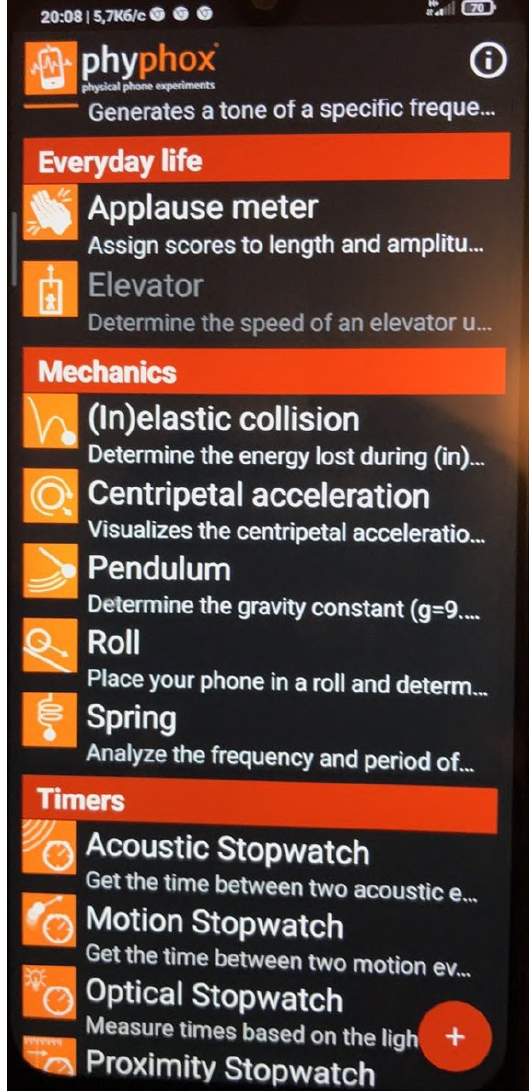
Figure 4: Phyphox at